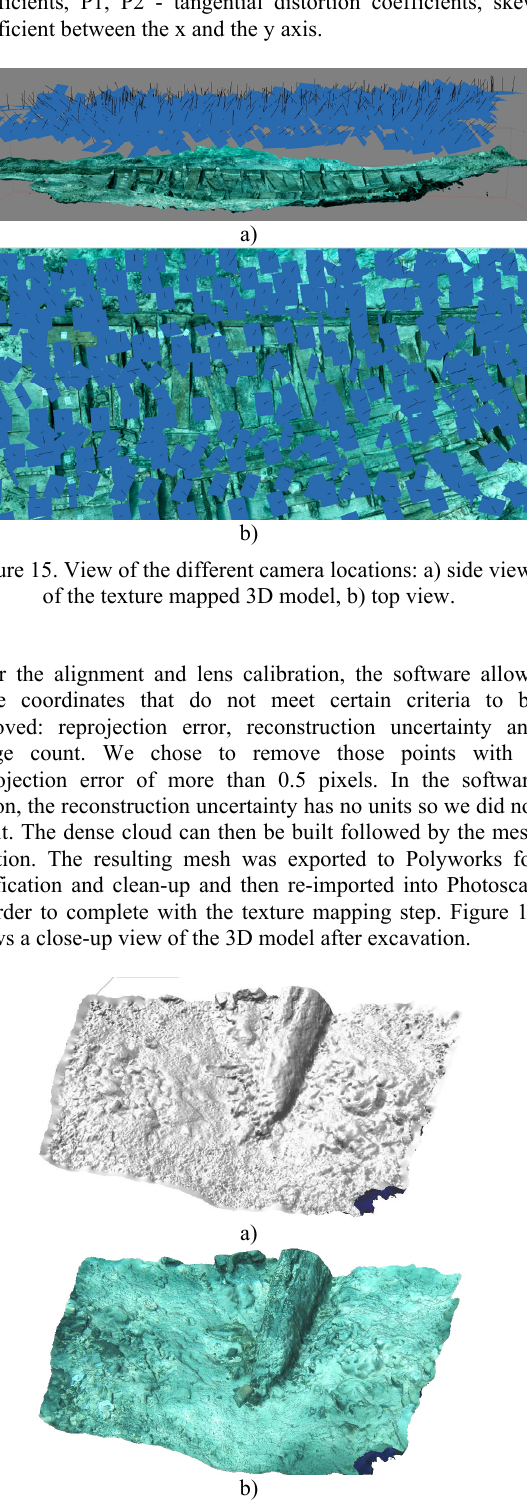
Figure 16. Close-up view of the 3D model created with Photoscan and images acquired after the excavation: a) shaded view, b) texture mapped